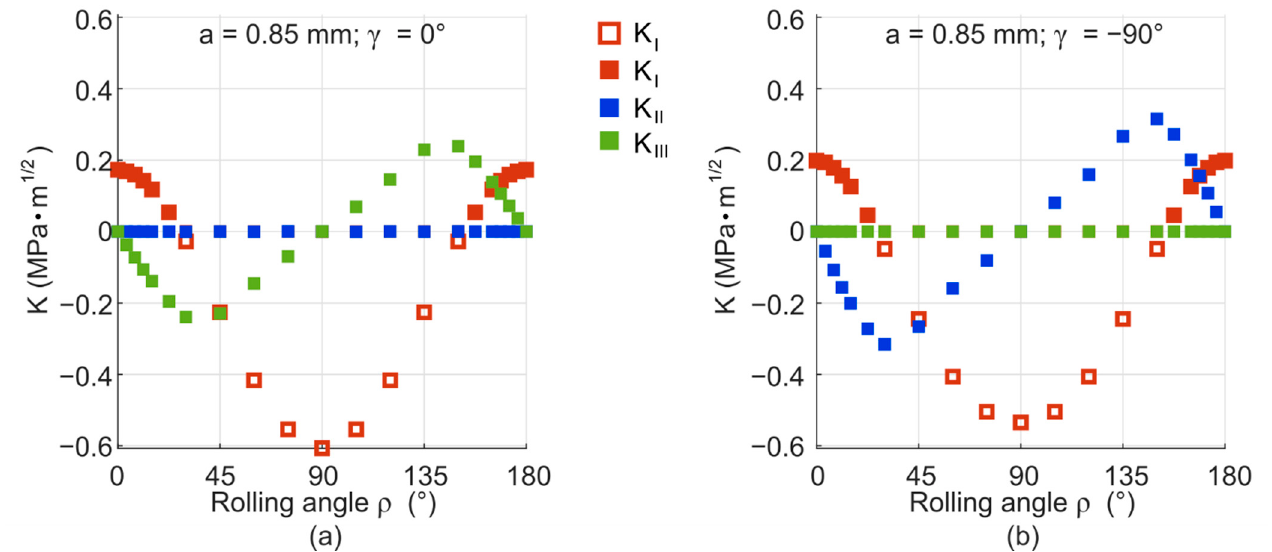
Figure A7. Course of stress intensity factors during rotation in the cylinder D × L = 6 × 6 mm 2 , load F = 350 N, a = 0.85 mm, position on the crack front; ( a ) γ = 0°; ( b ) γ = − 90°. Model including friction.